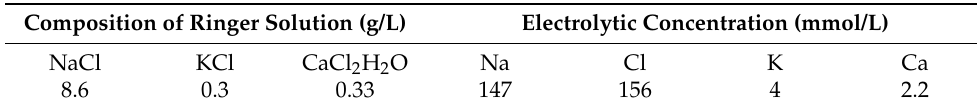
Table 3. Composition of Ringer solution used for corrosion